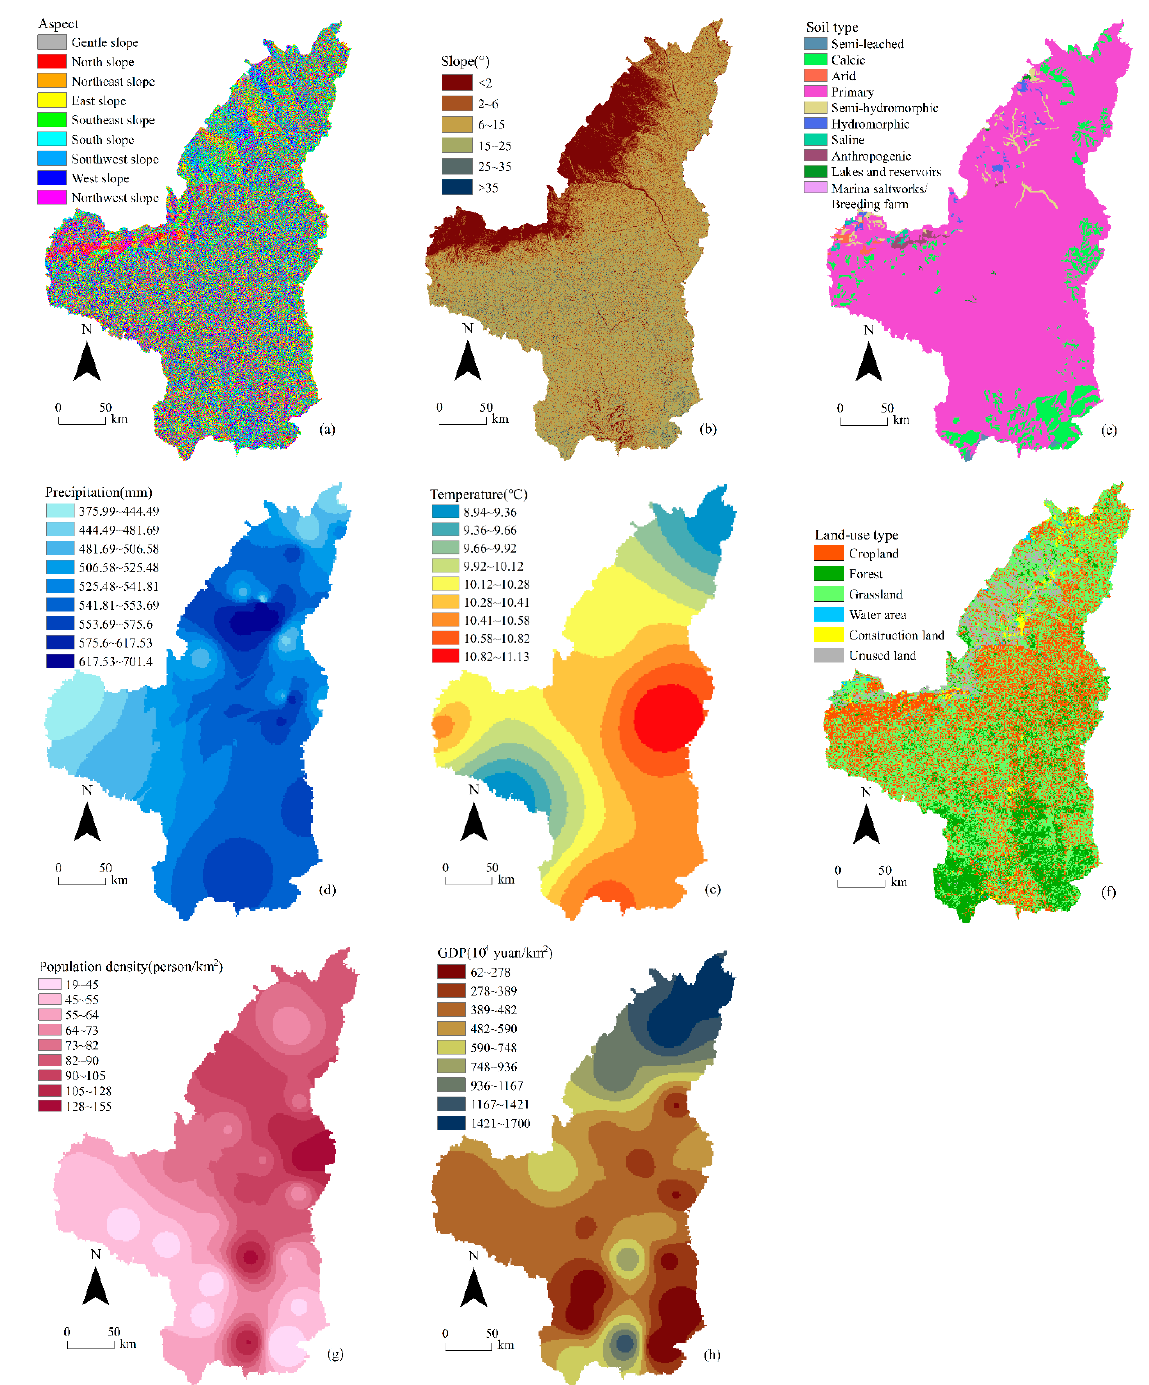
Figure 2. Spatial distributions of natural and human factors: ( a ) aspect; ( b ) slope; ( c ) soil type; ( d ) precipitation; ( e ) temperature; ( f ) land-use type; ( g ) population density; and ( h ) GDP.